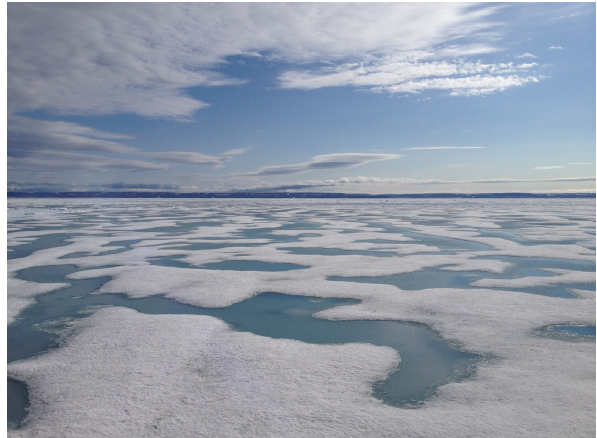
Figure 3. Picture of ponded FYI at the western end of Lancaster Sound on 20 July 2014. Also see Gourdal et al. (2018) for more pictures of melt pond cover in the same region and same